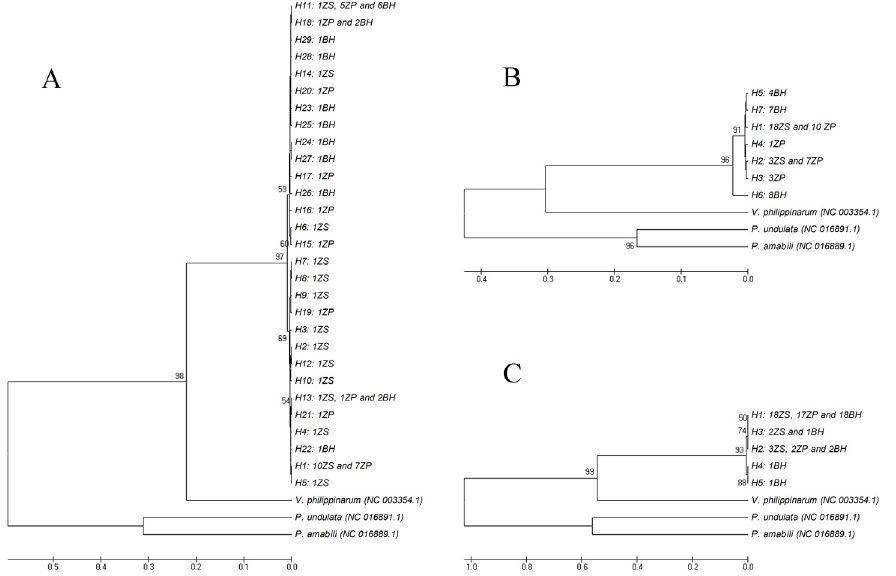
Fig 3. Molecular phylogenetic trees for M . multifarius by using UPGMA based on COI (A), 12S rRNA (B), and NDI (C) gene sequence data using bootstrap test. Figures before population codes, which are behind the haplotypes, indicate that the number of individuals from the population belongs to the haplotype. All haplotypes are clustered in 1 branch, and the analyzed samples of M . multifarius are monophyletic with respect to the 3 out-groups: V . philippinarum (NC 003354.1), P . undulata (NC 016891.1), and P . amabilis (NC 016889.1) (100% bootstrap